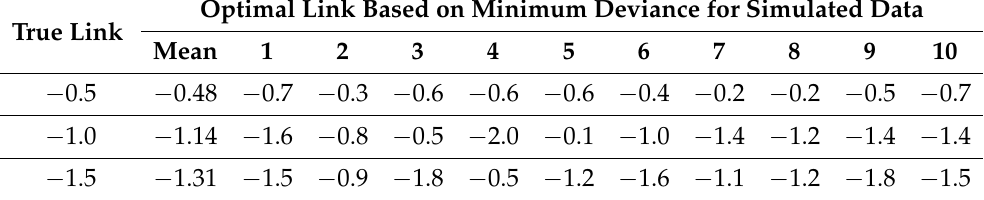
Table 4. Optimal IG link grid search on simulated